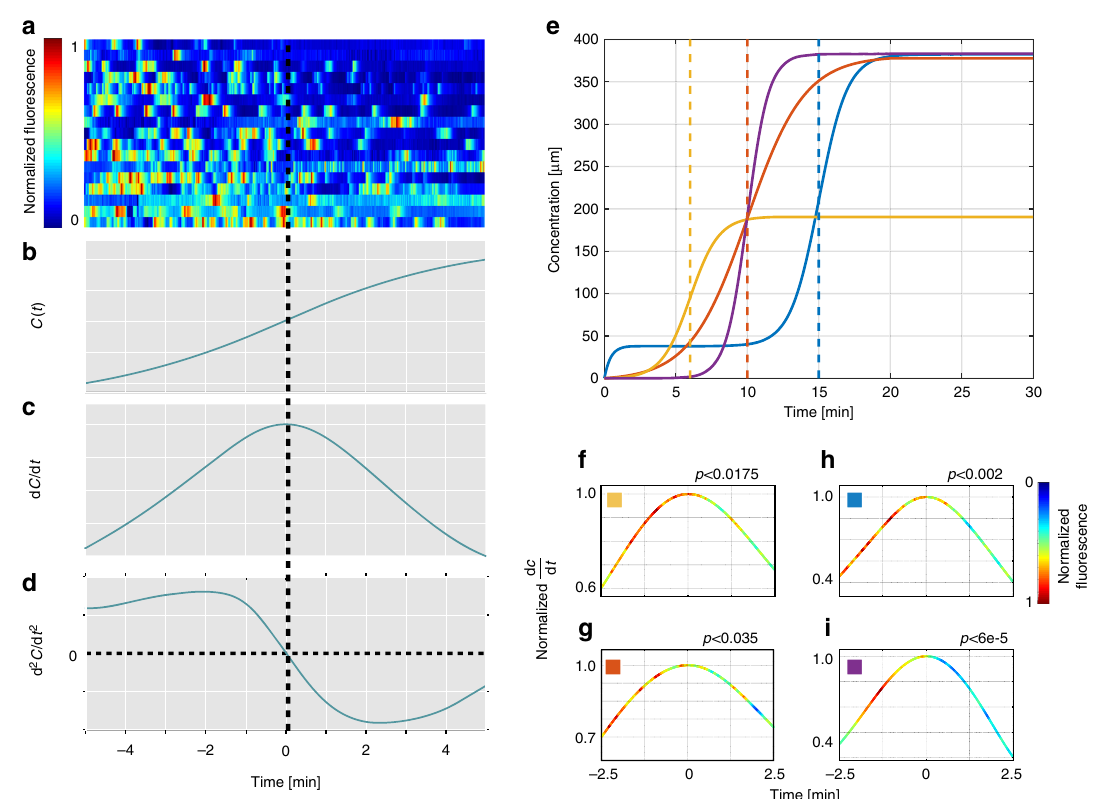
Fig. 3 Worms adapt to the magnitude of the fi rst derivative. a AWA neural responses in response to a sigmoidal gradient ( N = 17). Responses are aligned to: b concentration (a hyperbolic tangent function); c fi rst derivative, and d the second derivative of the concentration. Worms adapted to the levels of the fi rst derivative, and thus, neural activity dropped asymmetrically after the fi rst derivative peaked and the second derivative fl ipped signs from positive to negative. e Activity decrease after crossing the maximal fi rst derivative point was due neither to the prolonged exposure to the stimulus nor to the stimulus concentration. To eliminate those possibilities, we shifted the stimulus function in time, and changed its absolute concentration. The blue curve is the sigmoid function shown in a – d . The red curve was shifted back by 5 min, such that the peak of the fi rst derivative was reached after 10 min; the orange curve was shifted back by 9 min and reached absolute levels that were two-fold lower. The purple and the red curves reach the peak of the fi rst derivative exactly at the same time; however, the gradient of the purple curve is two-fold steeper at the midpoint. f – i The mean neural activity for the sigmoid functions shown in e . The curve shows the gradient fi rst derivative and the neural activity is color coded. In all cases, neural activity was signi fi cantly higher during the fi rst half of the gradient, before the fi rst derivative reached its maximal level (and where the second derivative was still positive) than during the second half, after the fi rst derivative crossed its maximal level (and where the second derivative became negative); f p < 0.02, N = 21; g p < 0.04, N = 12; h p < 0.002, N = 17; i p < 10 -4 , N = 15 (Wilcoxon signed-rank